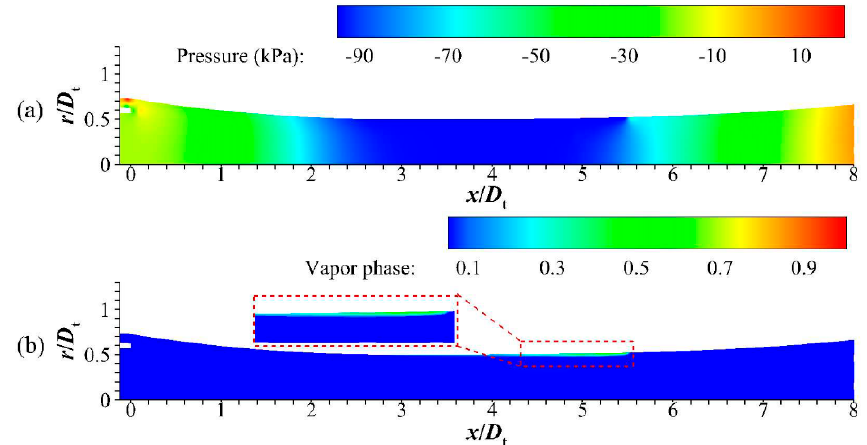
Figure 12. Pressure and vapor volume fraction distribution (SAJP, q = 0.68). ( a ) Pressure distribution; ( b ) Vapor volume fraction distribution.